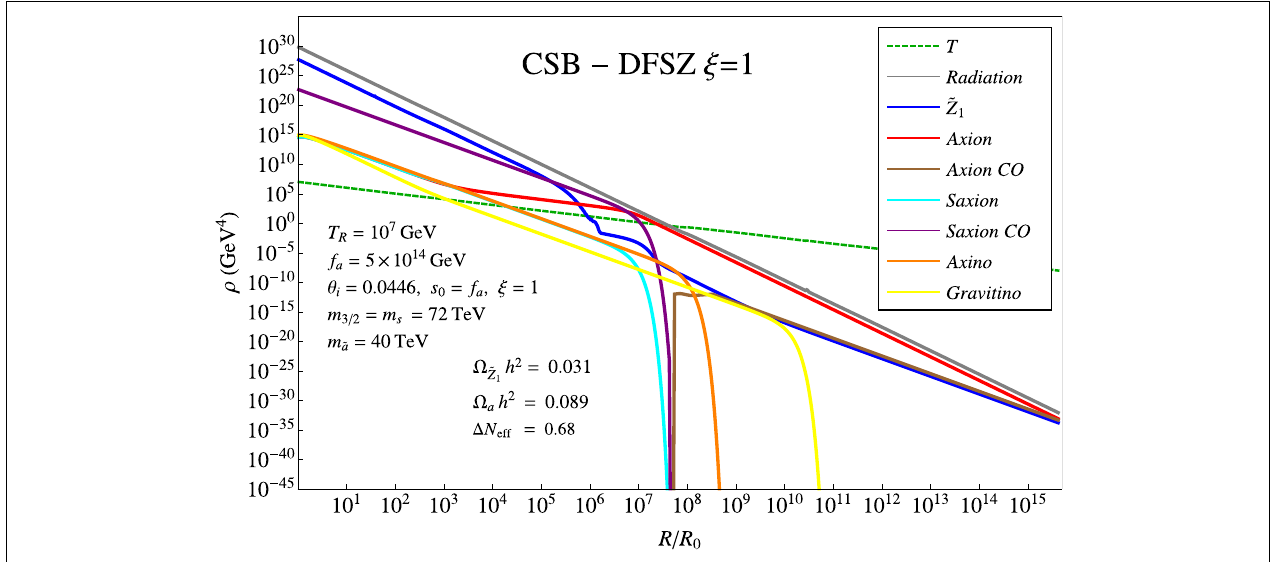
FIGURE 1 | Evolution of various energy densities vs. scale factor R / R 0 for the CSB benchmark case in SUSY DFSZ with ξ = 1 and other parameters as indicated in the figure.